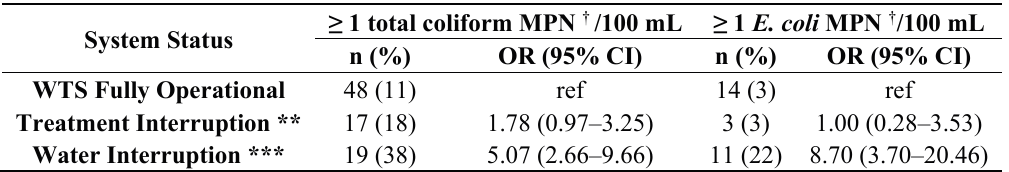
Table 5. Proportions and odds ratios of water samples with total coliforms and E. coli collected when water treatment systems were fully operational, during water quality interruptions and during water provision interruptions *